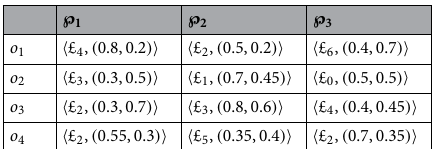
Table 1. q-rung orthopair linguistic decision matrix provided by d 1 .